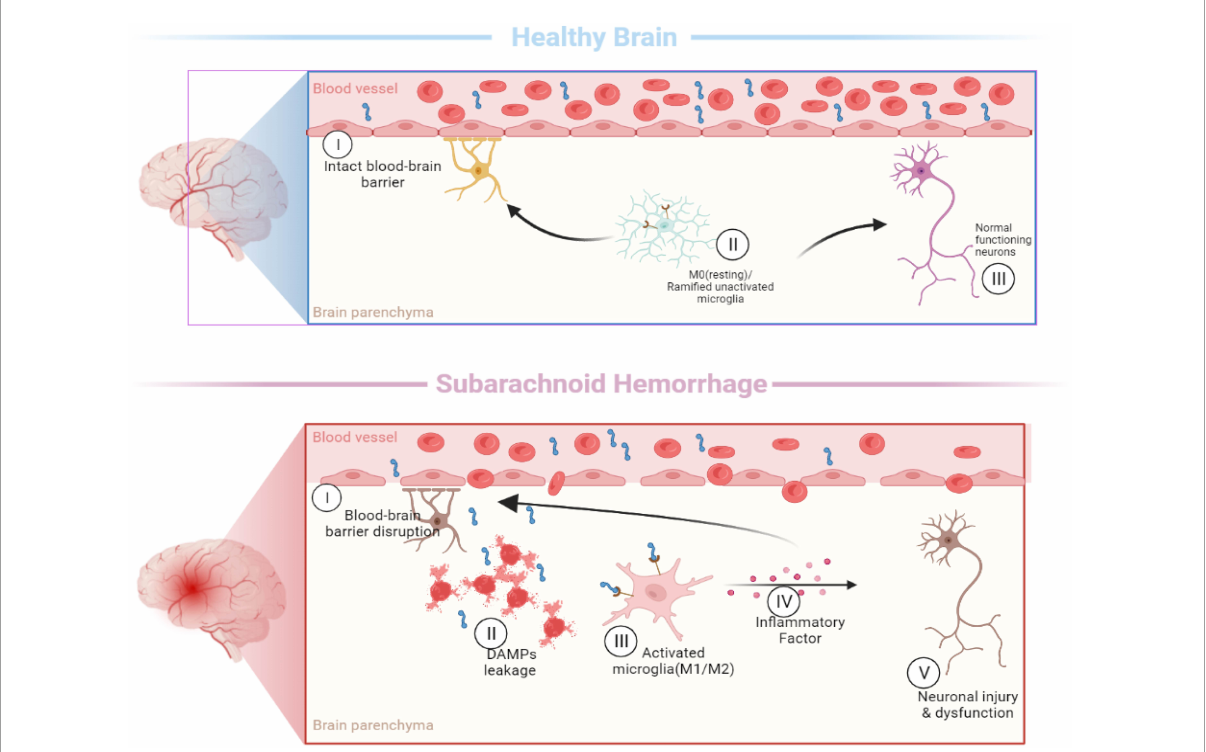
FIGURE2 Activation of microglia [In the healthy brain, the typical morphology of M0 microglia is highly branched, with many short and thin processes. When the subarachnoid hemorrhage occurs, microglia are rapidly activated and undergo morphological changes (M1/M2), including enlarging the cell size, shortening the processes, and eventual disappearance of